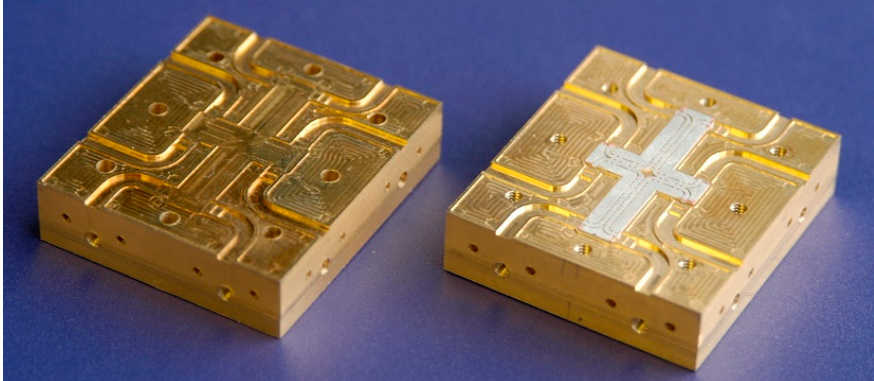
Figure 6. SIW multi-port in a brass fixture with standard WR-10 flanges.